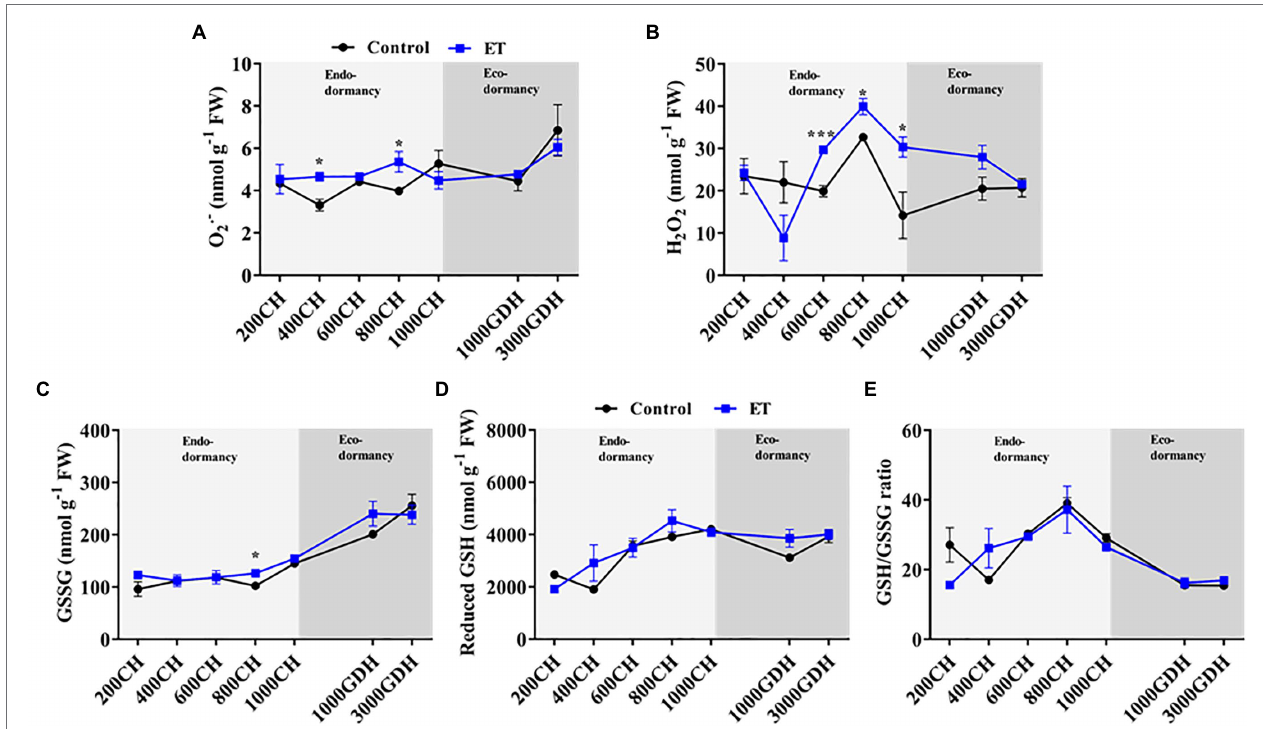
FIGURE 2 | Effects of the ethephon (ET) on the temporal changes of the reactive oxygen species (ROS) and glutathione-based redox during the dormancy in peach “Red haven” flowering buds. Superoxide radical (O 2• − ; A) , hydrogen peroxide (H 2 O 2 ; B) , oxidized glutathione (GSSG; C) , reduced glutathione (GSH; D) , and the GSH/GSSG ratio (E) . Data represent the mean ± SEM for n = 3. Asterisks indicate significant differences between the control and ET-treated plant buds at different chilling hours (CH) and growing degree hours (GDH); ∗ p < 0.05; and ∗∗∗ p <